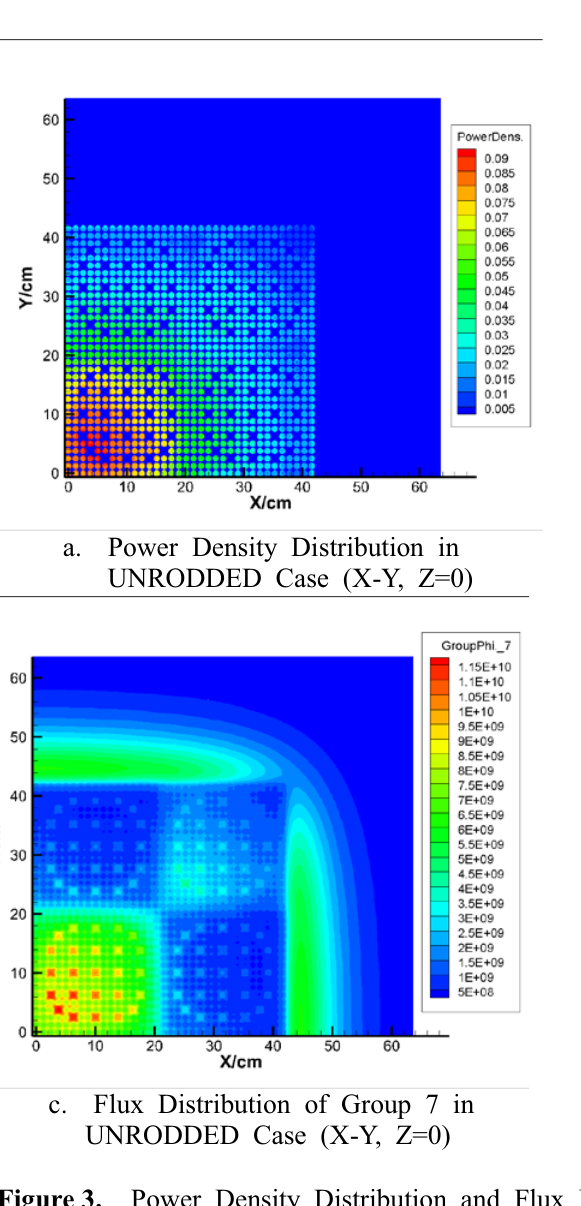
Power Density Distribution and Flux Distribution of Group 7 Form X-Y and Y-Z Cross-Section in UNRODDED